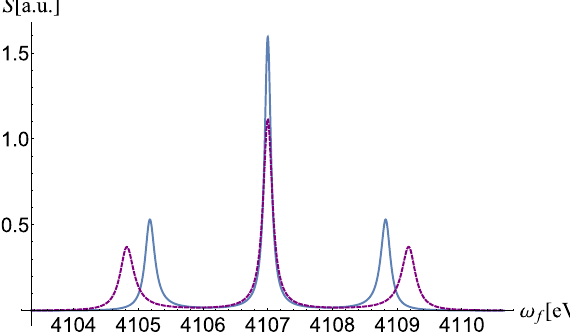
2 p 3 / 2 transition in Li-like uranium as a function of fluorescence ↔ ω 12 4106.6 eV. The laser intensity is 10 14 W/cm 2 . With blue = = 0 , and with purple (dashed) the case b =